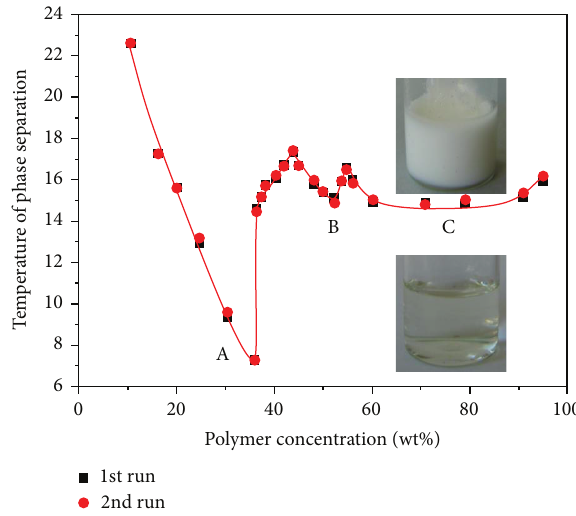
Figure 6: Phase diagram of linear copolymer PNIPA-SA/water system; onset values of LCST were taken from the TM-DSC (reversing heat flow) plots upon first and second heating at 5 ∘ C/min; lines are guides for the